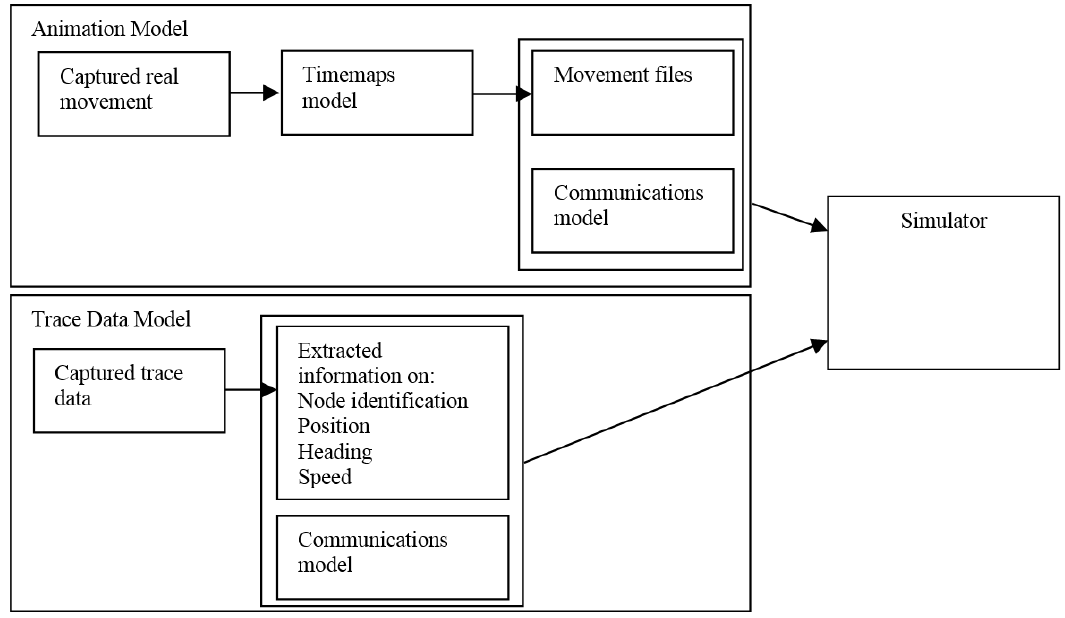
Figure 18. Transferability of animation and trace data models.